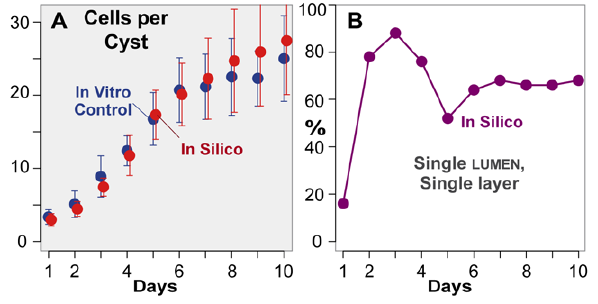
Figure 7. C YSTOGENESIS measures with no LUMINAL CELL DEATH . ISMA simulations executed with the parameter values from Table 2 except that LUMINAL CELL DEATH was not allowed. (A) Red: mean values and standard deviations for CELL number per CYST . Blue: in vitro control data from Figure 2A. (B) Percentage of SLSL CYSTS .